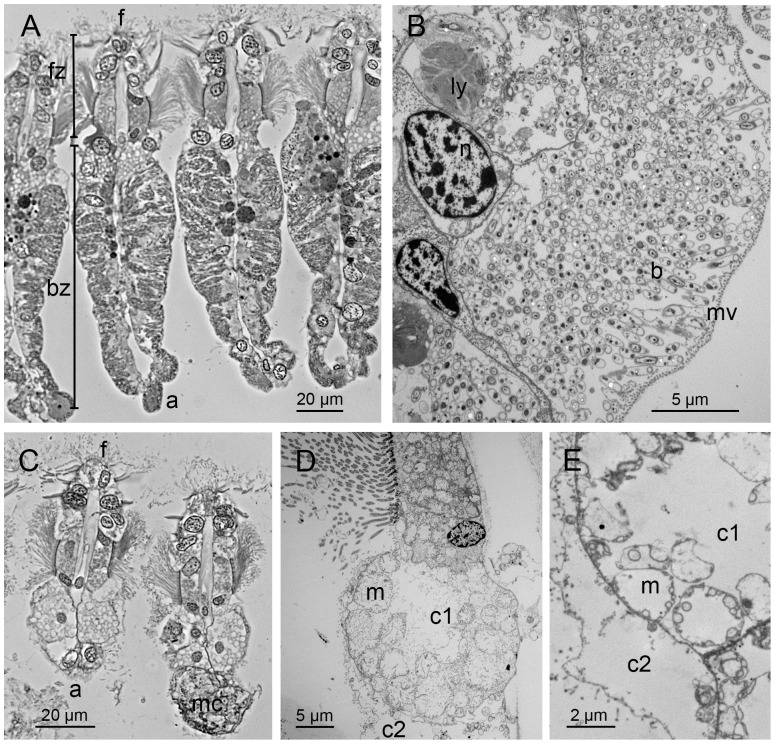
Light and electron micrographs of gill filaments of Thyasira cf. gouldi.
A. Symbiotic specimen. Light micrograph of a semi-thin, transverse section through four gill filaments. The ciliated frontal zone (fz) and bacteriocyte zone (bz) are highlighted. a: abfrontal end of a filament; f: frontal end of a filament. B. Symbiotic specimen. TEM of cells in the bacteriocyte zone of a gill filament, showing abundant bacteria (b), maintained extracellularly in pockets limited by extensions of host cell cytoplasm bearing microvilli (mv). Nuclei (n) and lysed remains of digested symbionts (ly) are visible in the host cell cytoplasm. C. Asymbiotic specimen. Light micrograph of a semi-thin, transverse section through two gill filaments. Note the shorter frontal (f) - abfrontal (a) length. mc: mucocyte. D, E. Asymbiotic specimen. TEM of cells in the abfrontal zone of a gill filament. Note the absence of bacteria. The epithelium is pseudostratified, with apical cells (c2) overlying basal cells (c1) containing large mitochondria (m). mv: microvilli.